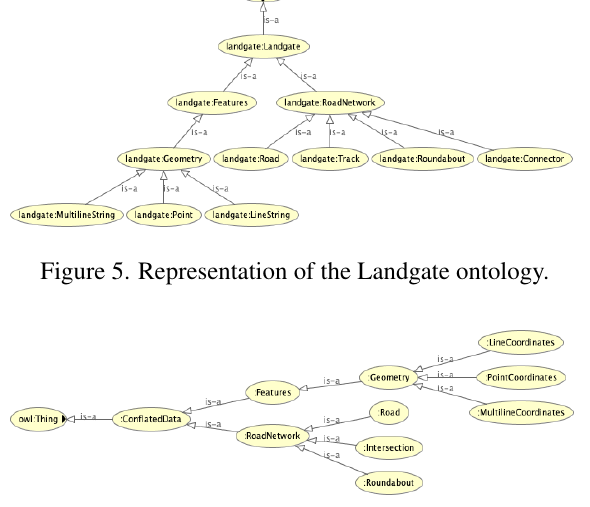
Figure 6. Representation of the conflated data